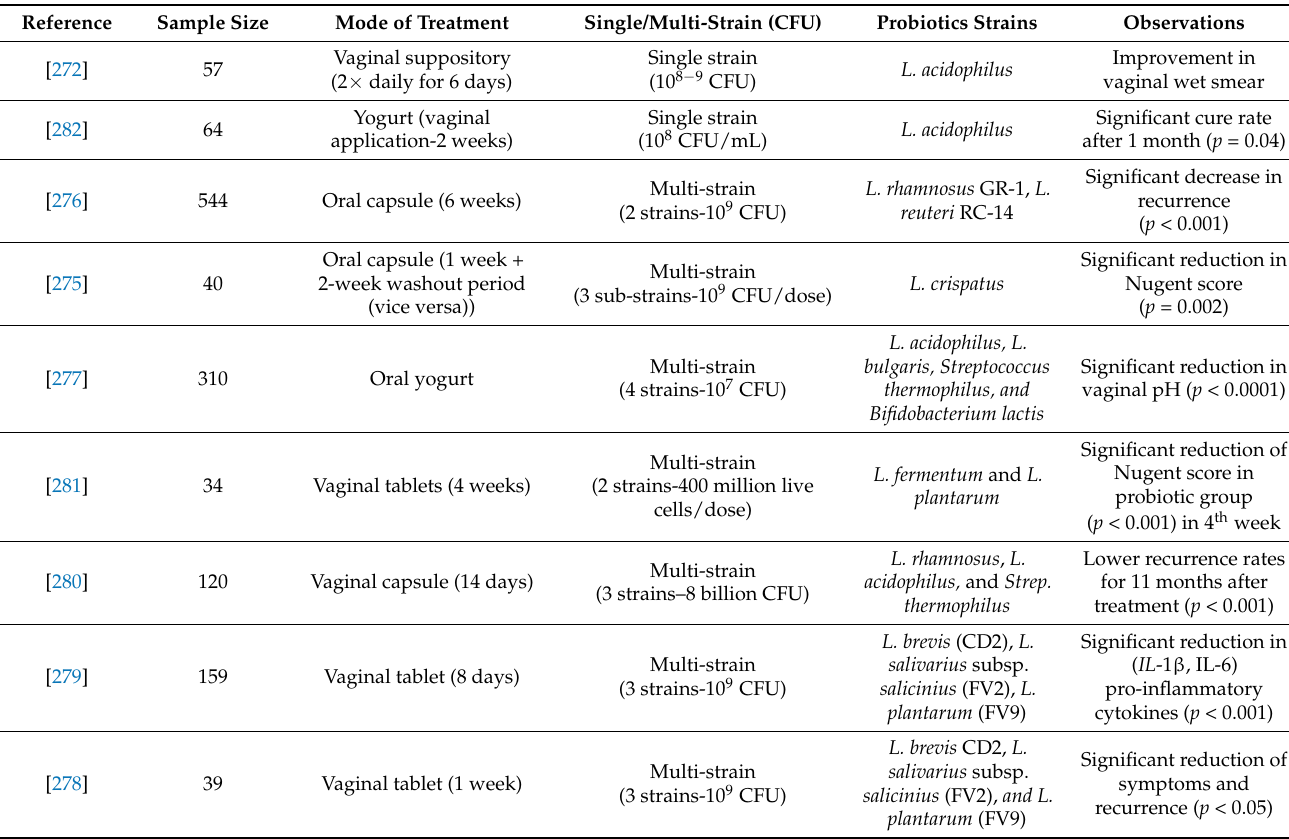
Table 6. Studies reporting the use of probiotics only for the treatment of BV (Randomized control trial).